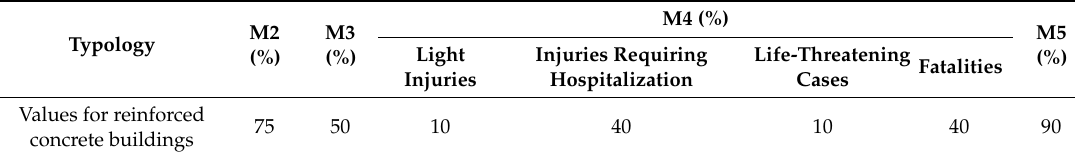
Table 5. The assumed values for the M2–M5 parameters [32].